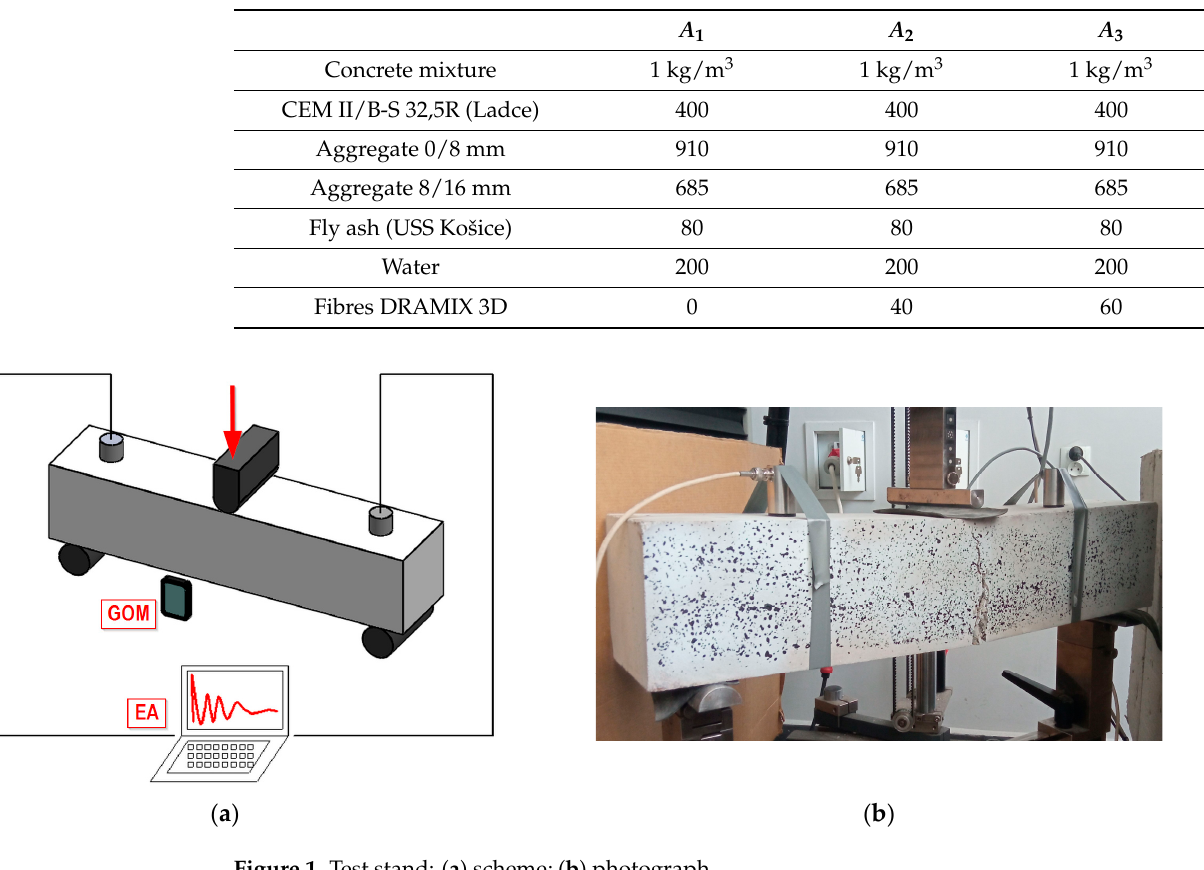
Table 1. Compositions of samples.